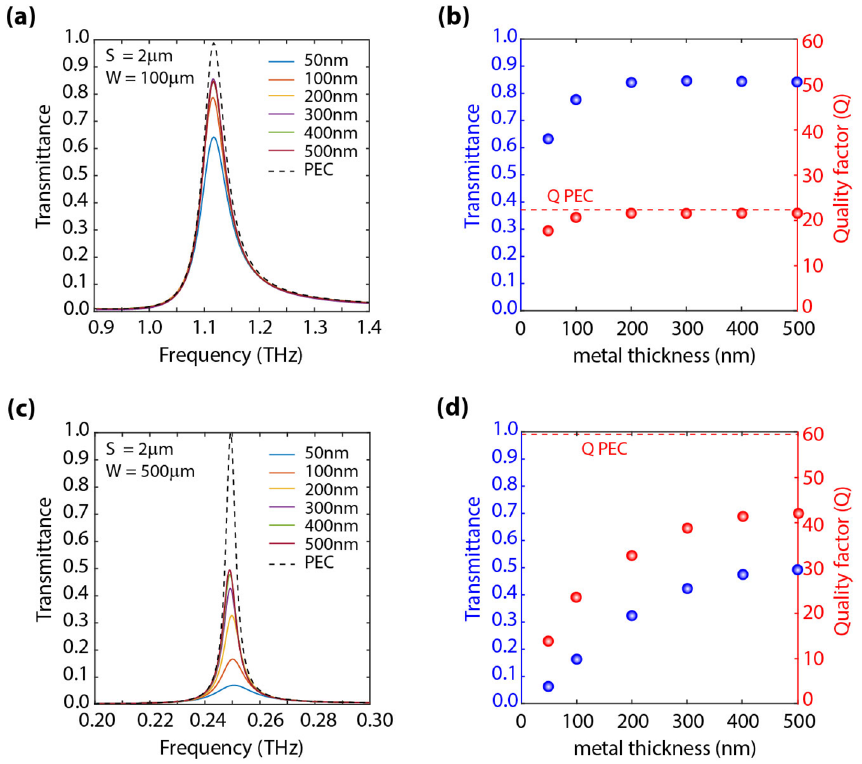
Figure 6. Effect of metal losses (finite conductivity) on the grating response. ( a , c ) Simulated transmittance spectra for different metal thicknesses (gold) for a grating with ( a ) W = 100 µm and ( c ) 500 µm. In both cases, S was set to 2 µm. ( b , d ) Transmittance spectra at resonance, i.e., ~ 1.1 THz and ~ 0.25 THz, when varying metal thickness for a grating with (b) W = 100 µm and ( d ) 500 µm. When comparing ( b , d ) is observed that the